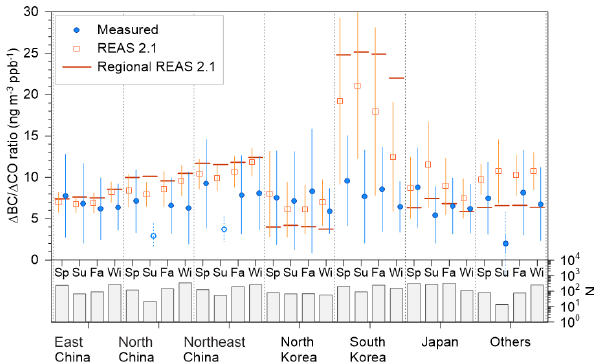
Figure 4. The seasonal (cid:49) BC /(cid:49) CO ratios from four measurement sites (filled blue circles) and recalculated REAS BC / CO ratios ac- cording to the pathway of the trajectory (open orange squares), de- pending on the dominant emission region. The symbols with verti- cal lines are the means and standard deviations of the (cid:49) BC /(cid:49) CO ratios. Open-circle symbols with dashed vertical lines indicate data excluded because of a low number of data ( ≤ 50). The horizon- tal lines for each region indicate the overall mean values of the (cid:49) BC /(cid:49) CO ratios of dominant emission regions from the REAS version 2.1 emission inventory (Kurokawa et al., 2013). The bar graph on the bottom indicates the number of data in each season and the dominant emission region. The abbreviations “Sp”, “Su”, “Fa”, and “Wi” indicate spring, summer, fall, and winter,